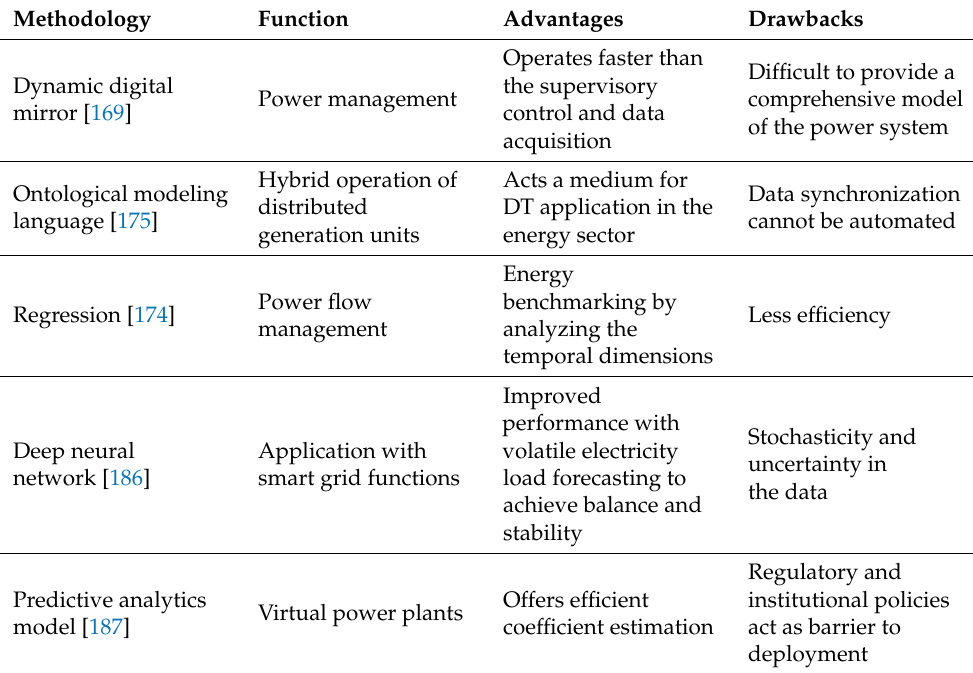
Table 11. Related work grid-connected system with digital